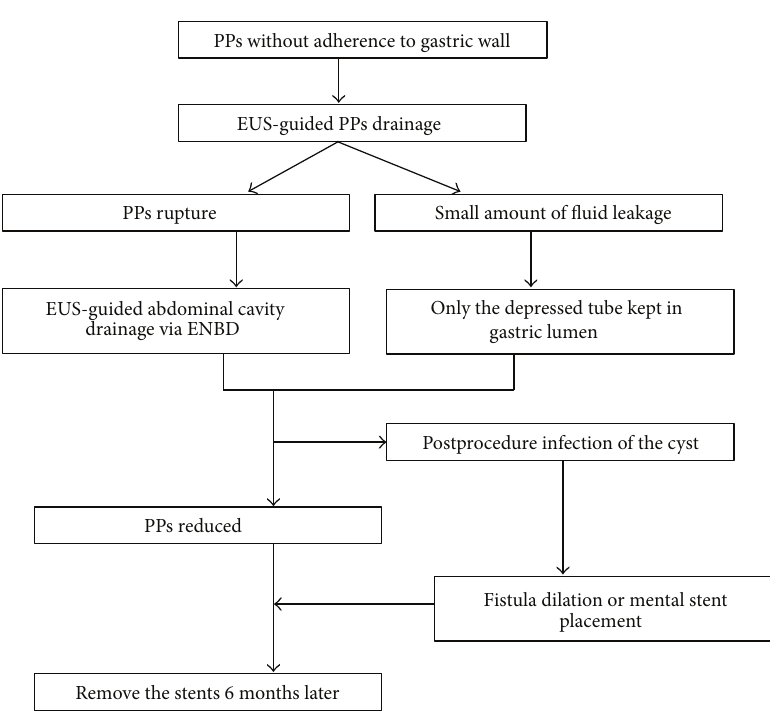
Figure 2: The patient candidate for our study is following the steps in chart.